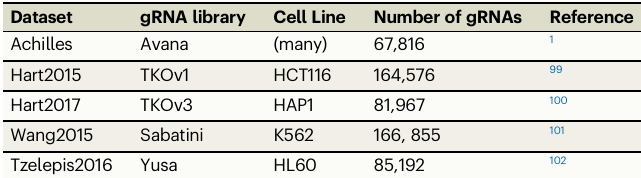
Table 4 | Genome-wide human CRISPRko screen datasets used for comparing SpCas9 gRNA